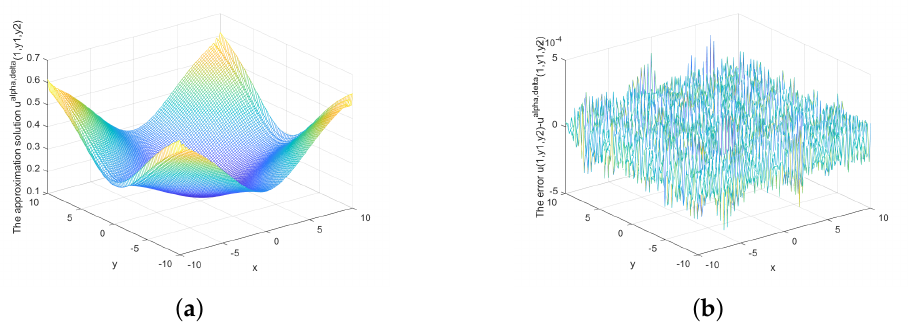
Figure 17. ( a ) The regularized solution and ( b ) error between regularized and exact solution when x = 0.3, δ = 1 × 10 − 6 under posterior